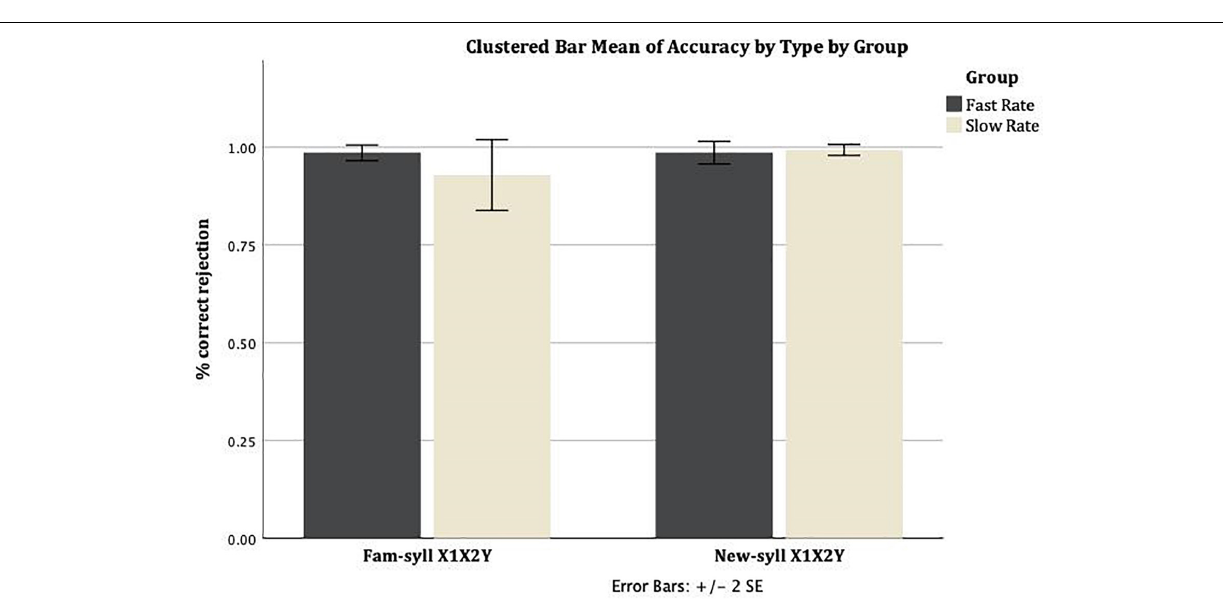
FIGURE 2 | Mean rate of correct rejection for Familiar-syllable X1X2Y and New-syllable X1X2Y strings in both conditions: Fast Rate and Slow Rate. Error bars show standard error of the